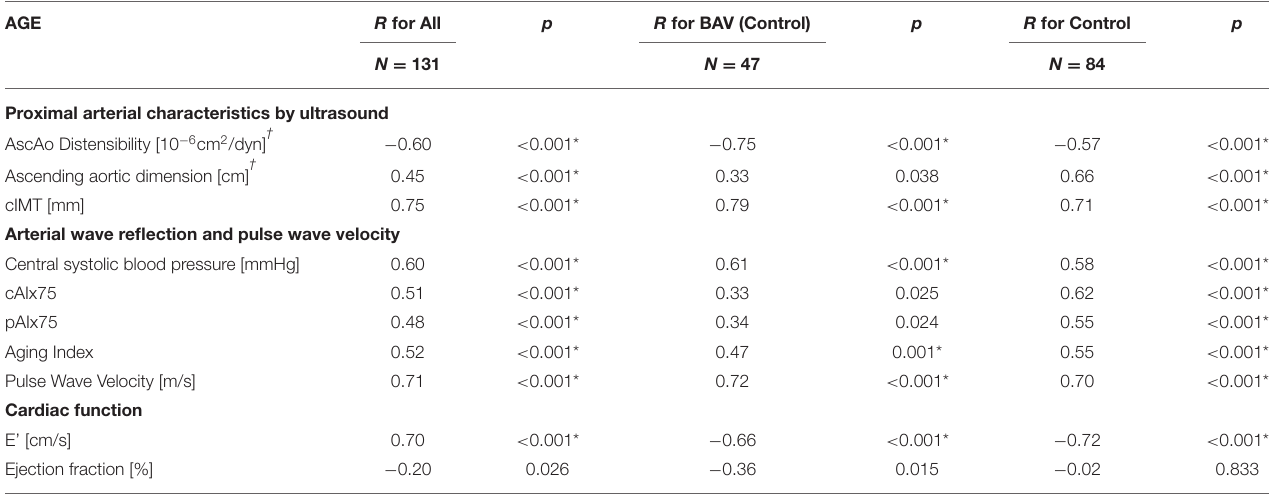
TABLE 6 | Correlations between age and cardiovascular characteristics for all patients as well as group-wise analysis for BAV patients and controls. AGE R for All p R for BAV (Control) p R for Control p N = 131 N = 47 N = 84 Proximal arterial characteristics by ultrasound † − AscAo Distensibility [10 − 6 cm 2 /dyn] 0.60 < 0.001* − 0.75 < 0.001* − 0.57